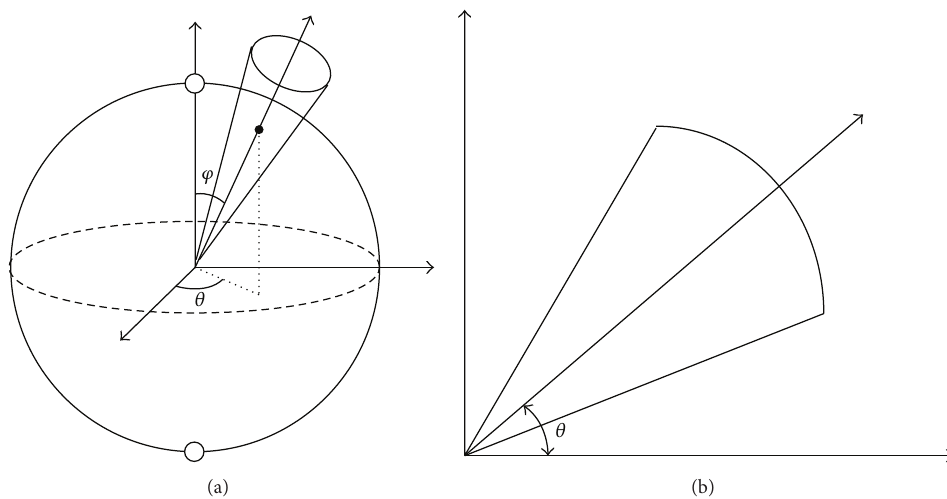
Figure 9: Comparison between a circular sector for direction 𝜃 in 2D case (b) with a conical body produced for direction (𝜃,𝜑) in 3D case (a).